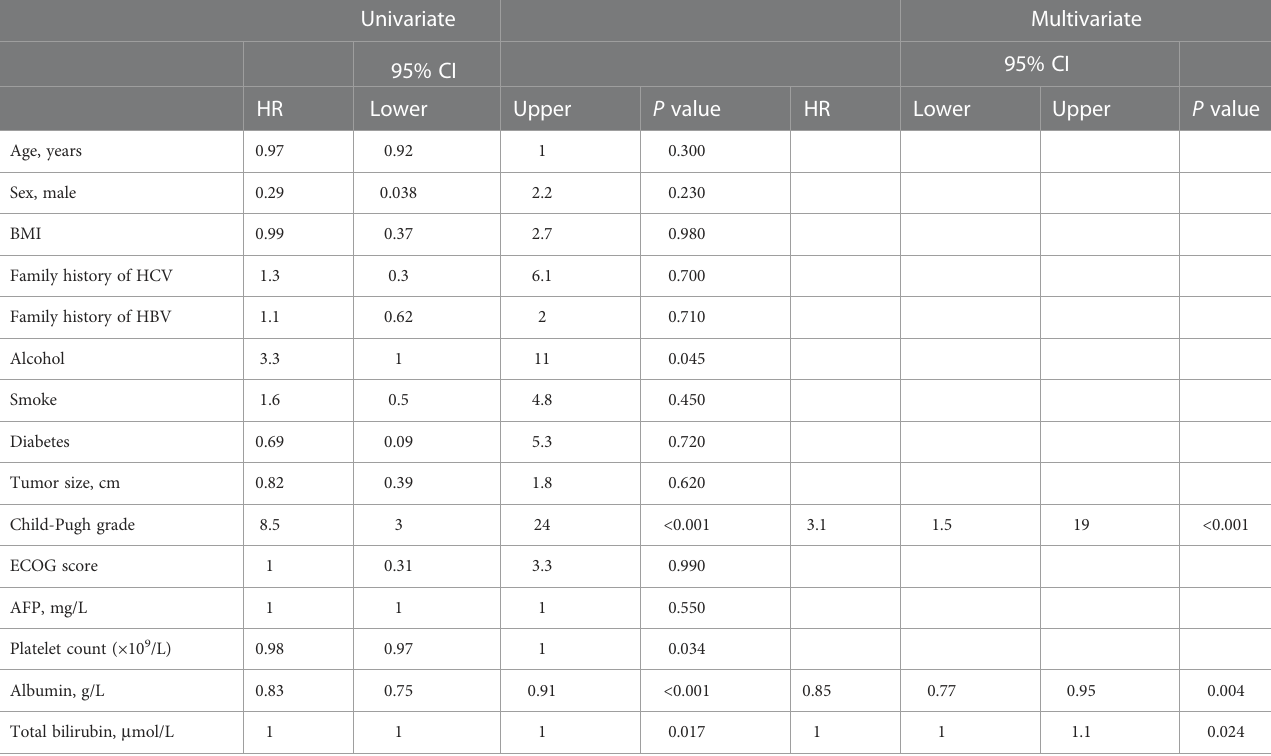
TABLE 5 Univariate and multivariate analyses of factors associated with overall survival (OS). Univariate